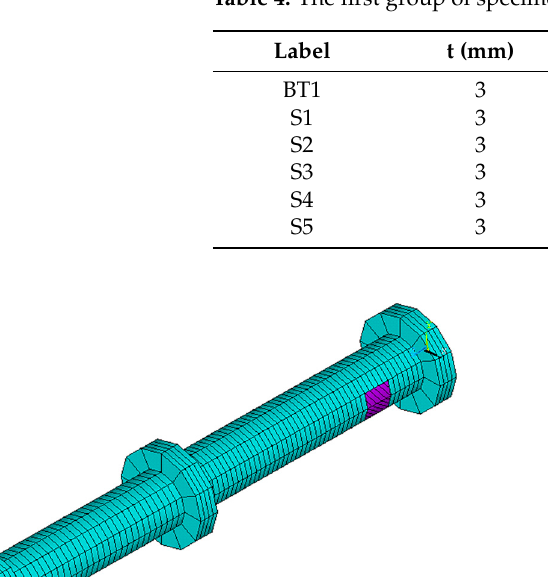
Table 4. The first group of specimens of parametric case studies.